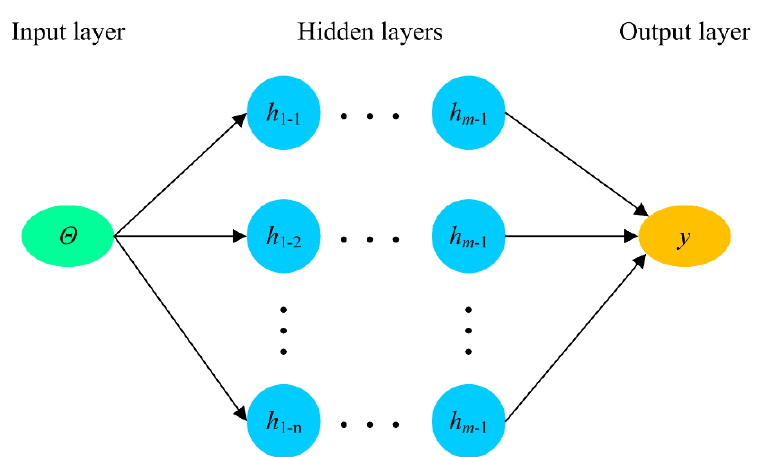
Figure 2. MLP approach structure diagram.